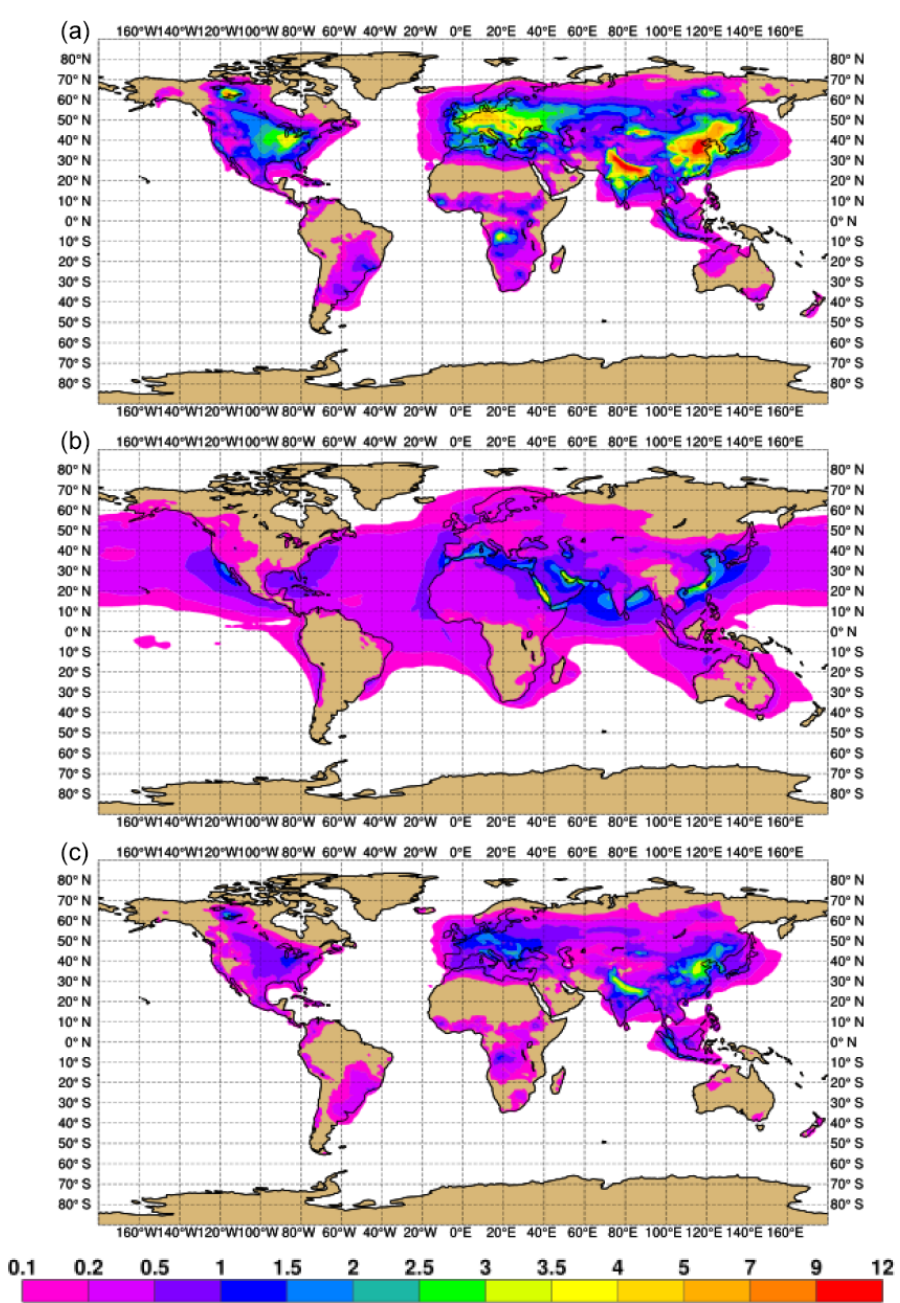
Figure 7. The 2014 average of surface fine-mode and (a) coarse-mode (b) nitrate mass concentration and ammonium (c) surface concentration (µgm − 3